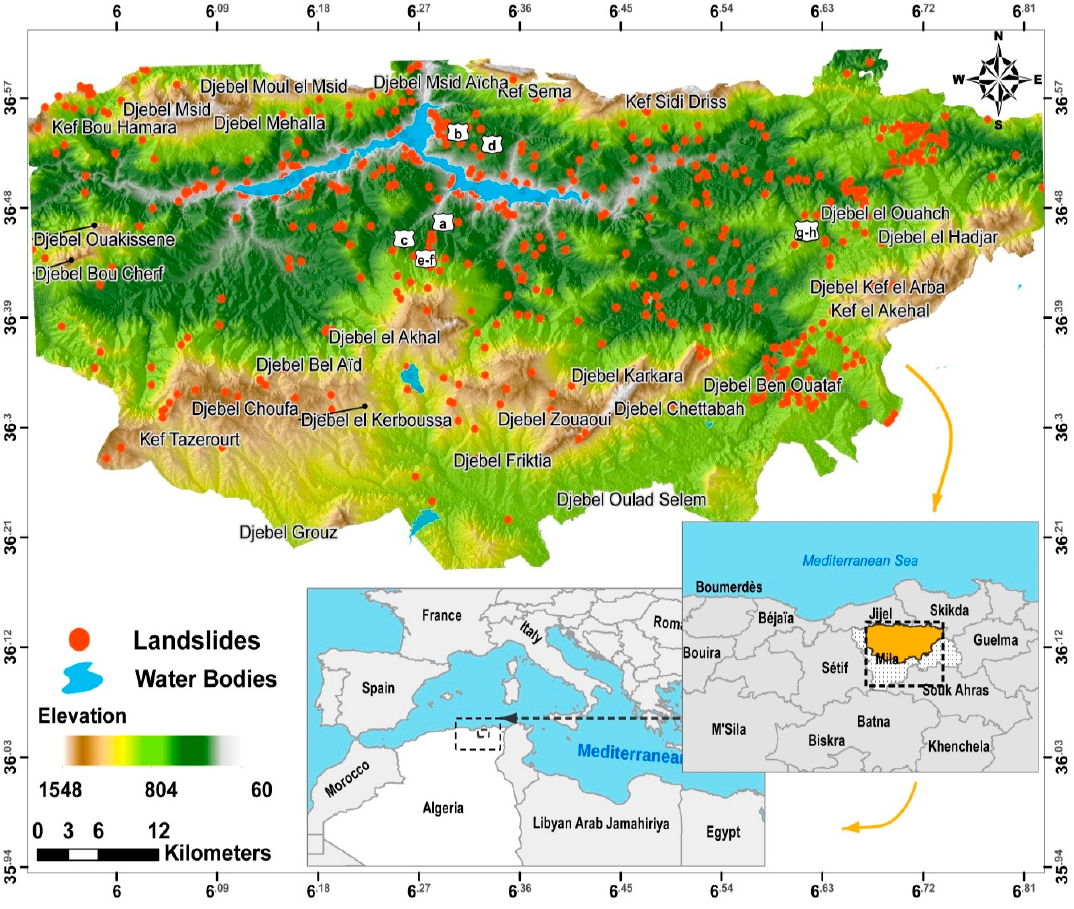
Figure 1. The landslide inventory map and location of the study Figure 1 . The landslide inventory map and location of the study area.